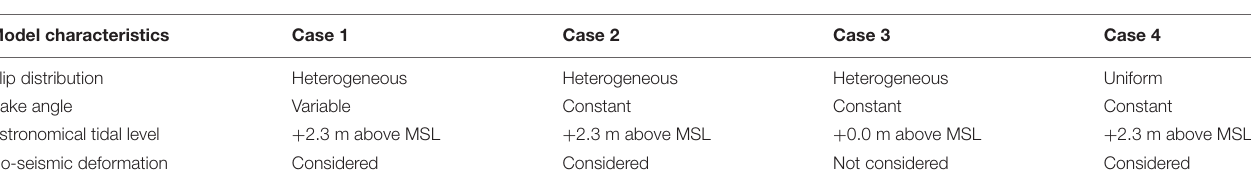
FIGURE 11 | Initial water dislocation profiles due to earthquake rupture (i.e., co-seismic deformation): (A) the USGS model with the variable rake angle (Case 1), (B) the USGS model with the constant rake angle (Cases 2 and 3), and (C) the USGS model with the uniform slip distribution with the constant rake angle (Case 4). TABLE 2 | Tsunami inundation simulation